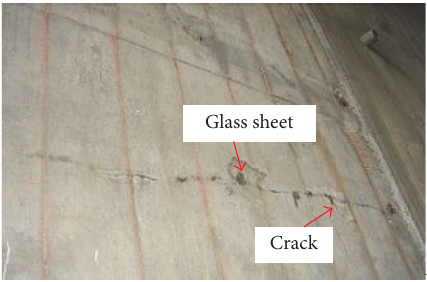
Figure 1: Yesanhe Super Large Bridge in construction.